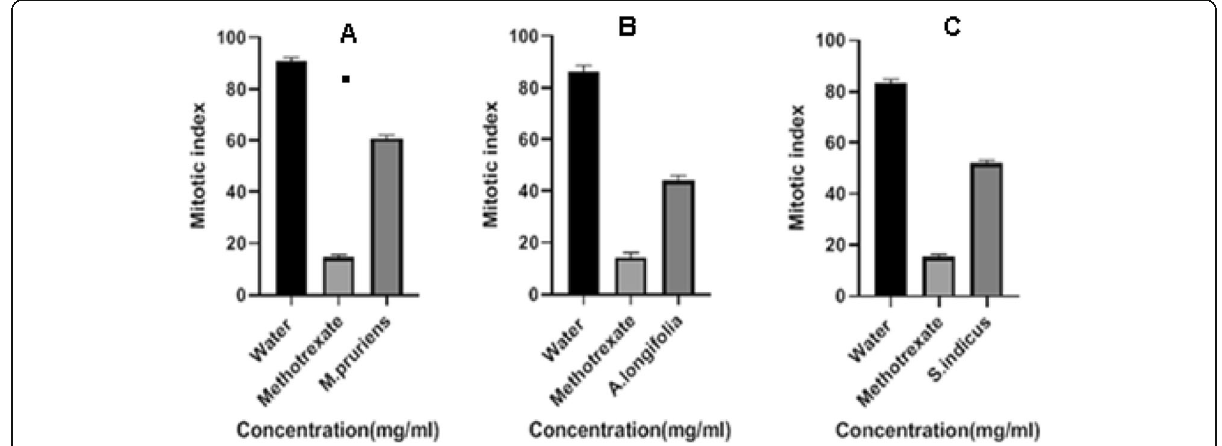
Fig. 3 Mitotic index (MI) comparison between water, methotrexate and plant extracts of a M. pruriens , b A. longifolia and c S. indicus